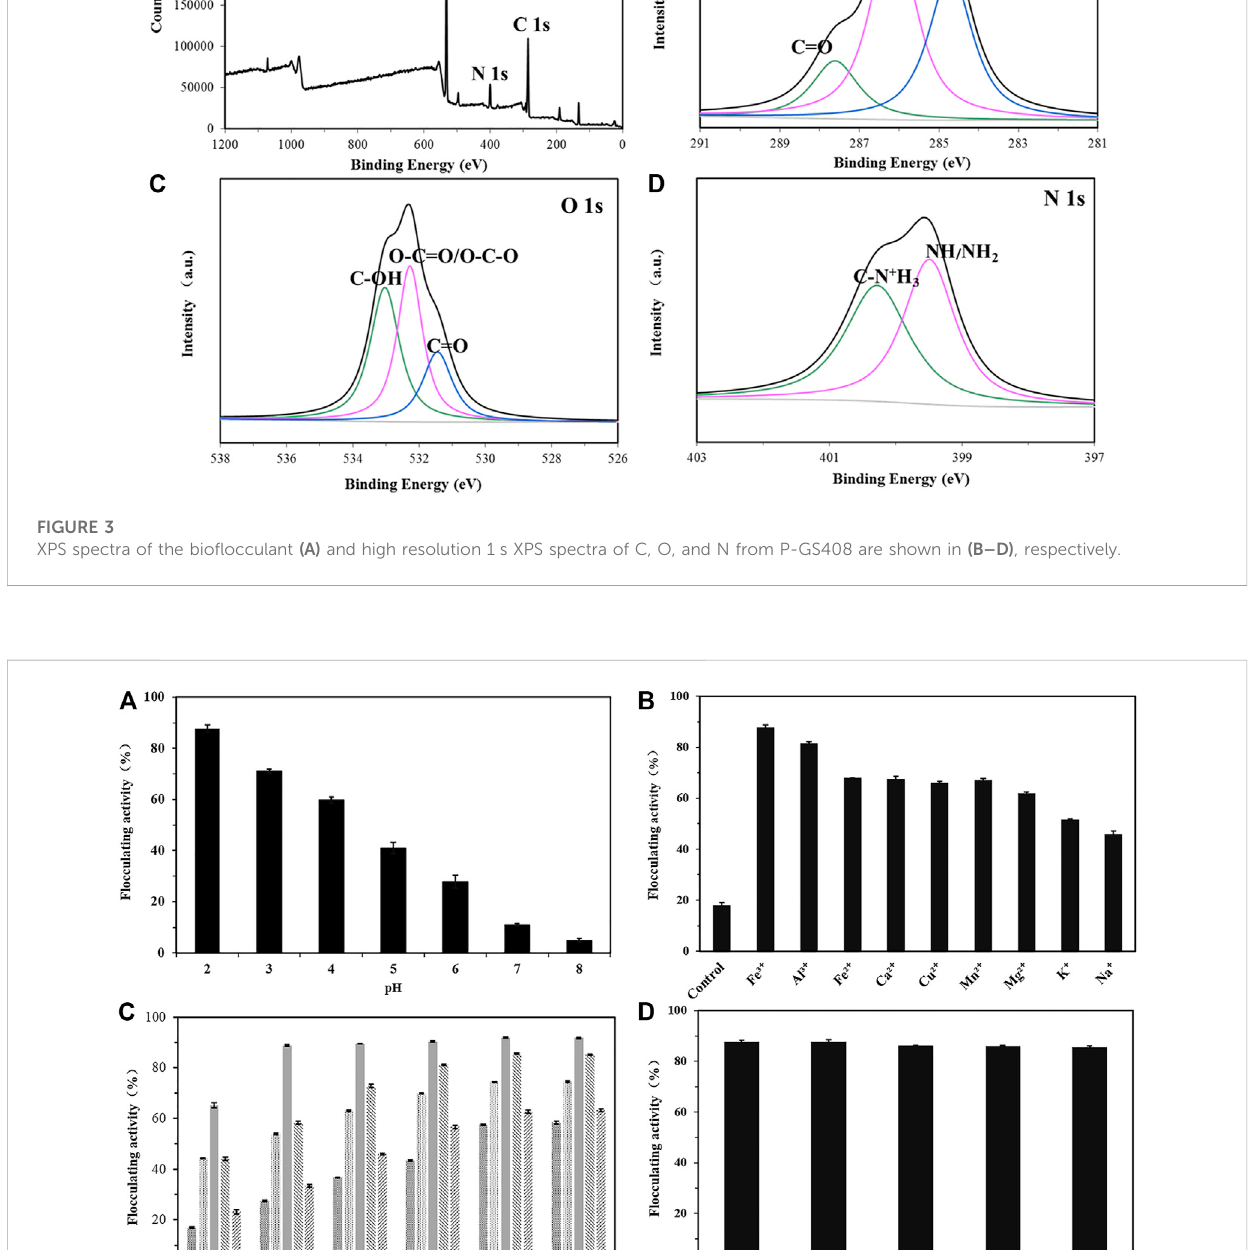
Frontiers in Bioengineering and